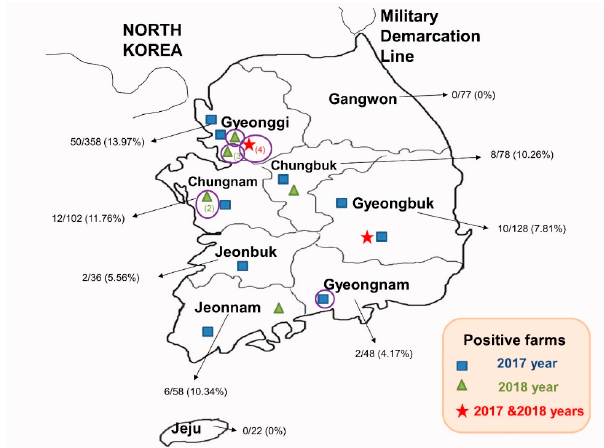
Figure 1. Distribution of total PEDV -positive swine farms in nine provinces of South Korea from 2017 to 2018. Marks (square, triangle, and star) indicated the locations of the swine farms. If the swine farms were located in the adjacent spot, the number of these swine farms was indicated in parentheses below the marks. The sample numbers (positive samples/total samples) and detection rate of each province are indicated by black arrows. The purple circles indicate the PEDV -positive farms where seven Korean PEDV strains sequenced in this study originated.